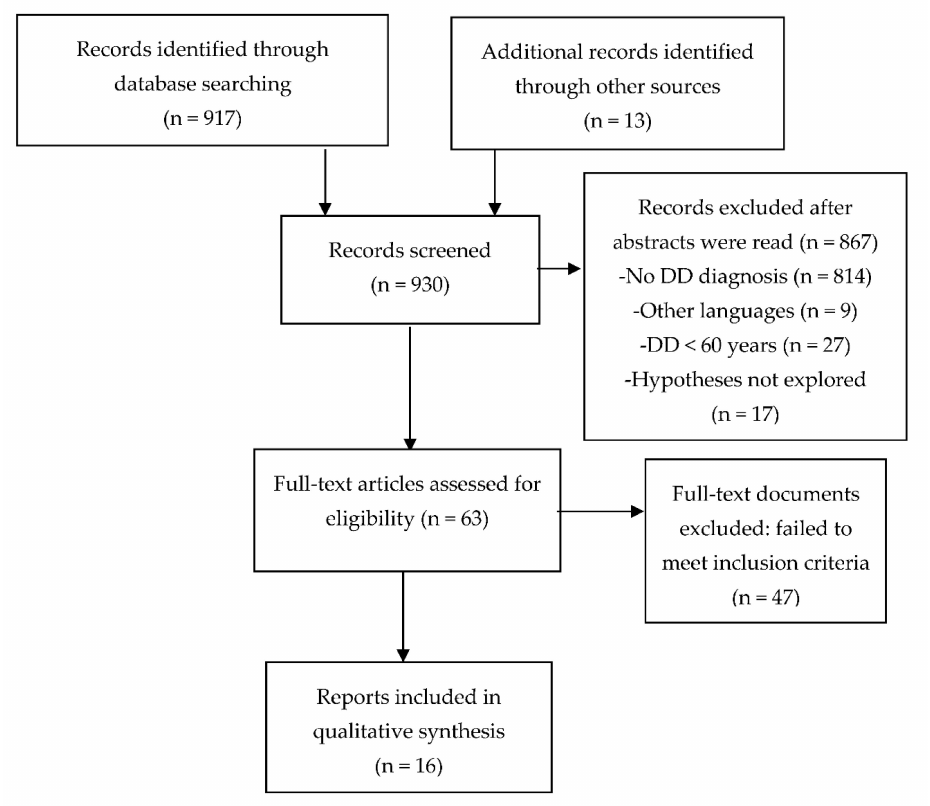
Figure 1. Flow diagram of included